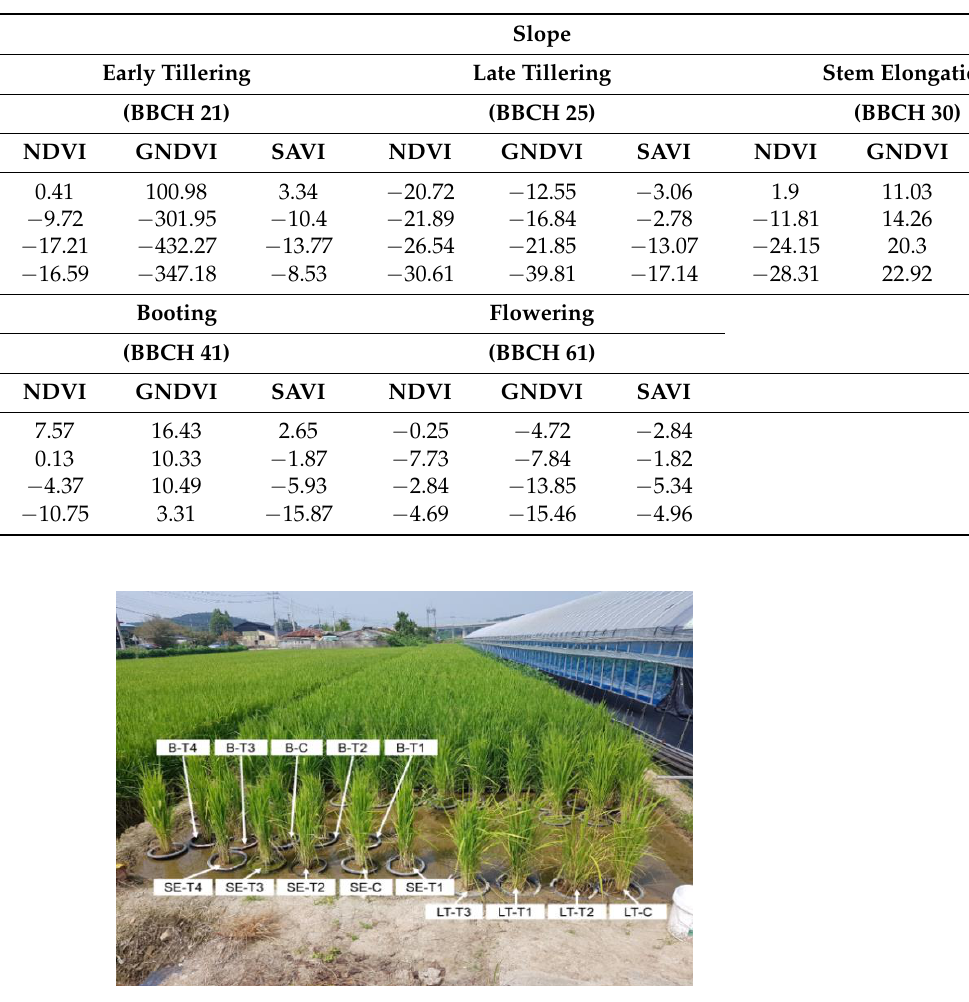
Figure A3. Correlation between chlorophyll contents measured using a microplate reader and the SPAD value. R and p refer to the Pearson correlation coefficient and p -value, respectively (* p < 0.05; ** p < 0.01; *** p < 0.001). References 1.